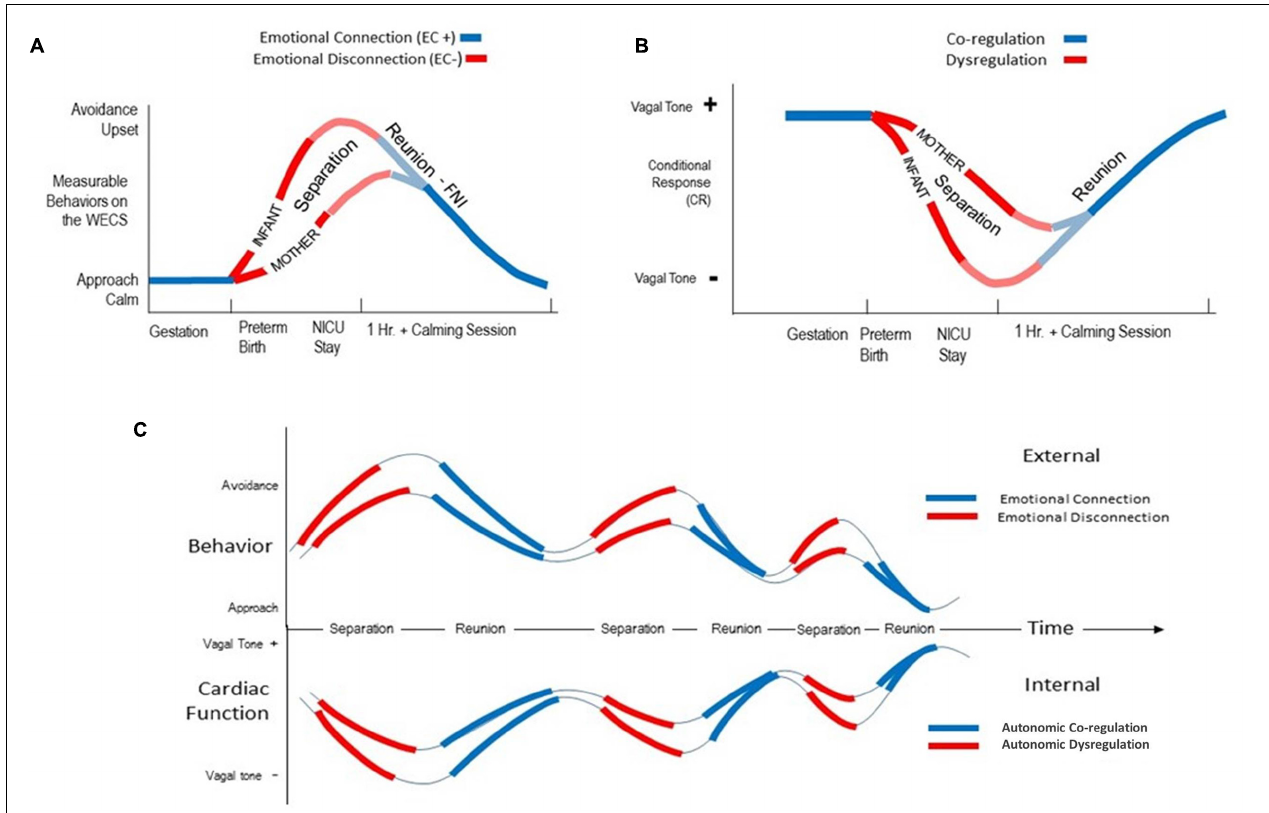
FIGURE 6 | Hypothesized relationship between perinatal behavior and cardiac function. Panel A depicts dyadic behavior over time in the NICU. Traumatic separation results in a break in emotional connection. Calming session restores dyadic calming. Panel B depicts the hypothesized autonomic cardiac function over time in NICU. Panel C depicts behavior and cardiac function together. The hypothesized calming cycle over time conditions the positive cardiac reflex and leads to emotional connection.